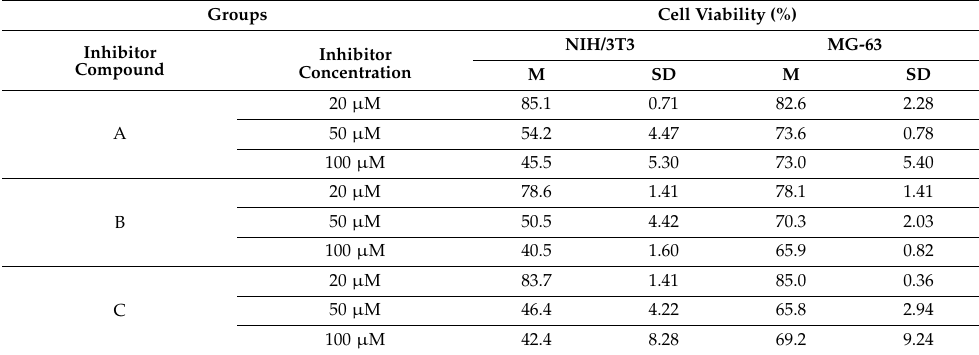
Figure 7. NIH/3T3 ( a ) and MG-63 ( b ) cell viability upon exposure to compounds A (4 (cid:48) -cyano-[1,1 (cid:48) -bihenyl]-4-yl methacrylate), B (5-((4 (cid:48) -cyano-[1,1 (cid:48) -biphenyl]-4-yl)oxy)pentyl methacrylate) and C (N,N (cid:48) -(oxybis(4,1-phenylene))bis(2- methylacrylamide). Table 4. Percentage of mean (M) and standard variation (SD) of cell viability for the two type of cells with the several inhibitor compounds in different concentrations.